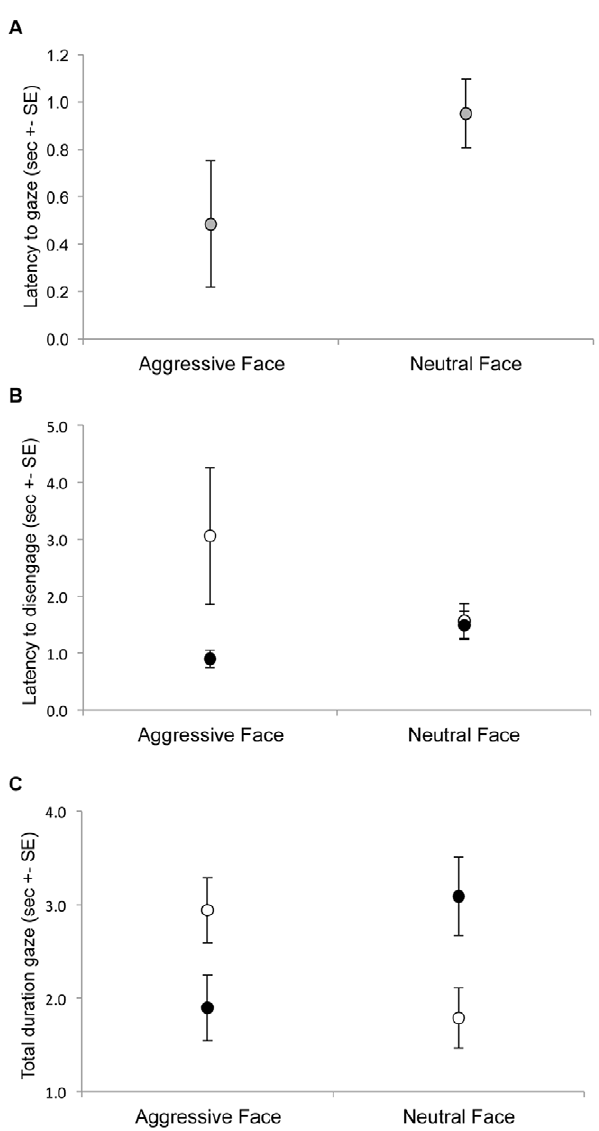
Figure 2. Social attention for aggressive-neutral face pairs. (A) Latency to gaze towards the aggressive or neutral face on experimental trials when each was the first stimulus to be looked at (pooled across conditions). (B) Latency to disengage first gaze from aggressive and neutral faces on experimental trials after the health check (filled circles) compared with during the enrichment condition (open circles). (C) Total duration of gaze towards aggressive and neutral faces after the health check (filled circles) and during the enrichment condition (open circles). All data indicate mean seconds 6 s.e.m.